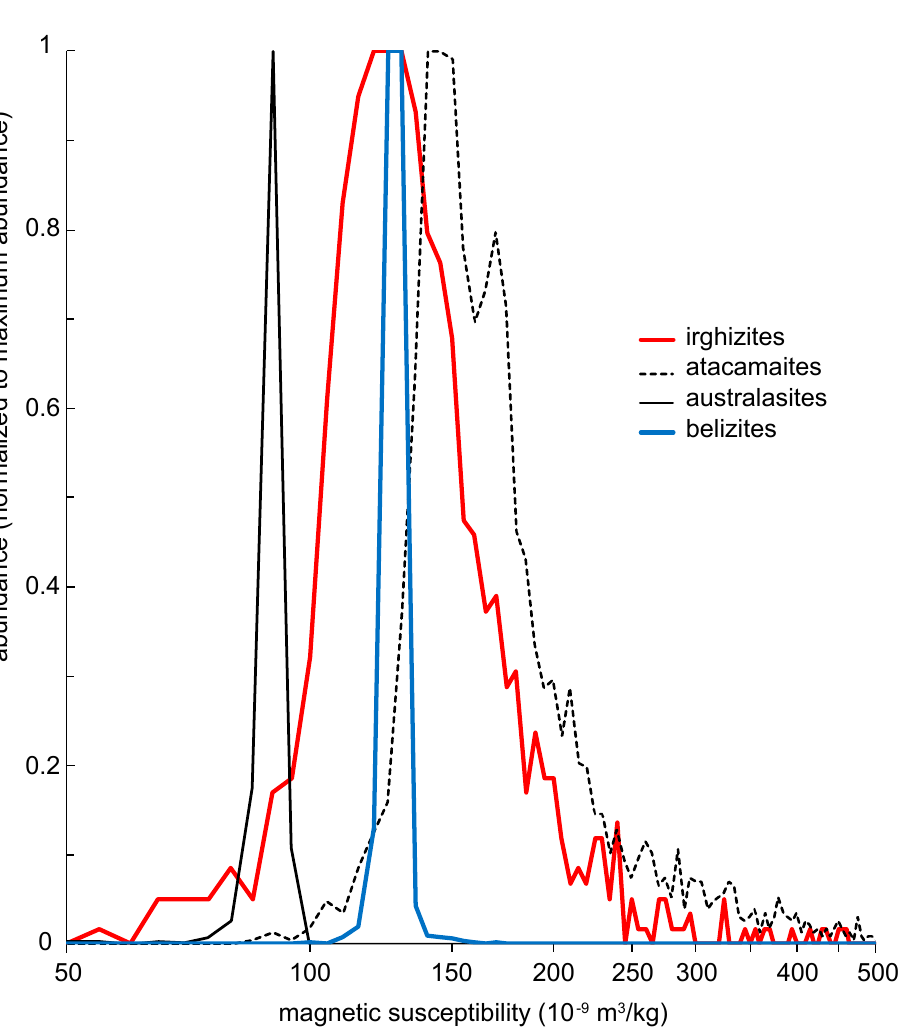
Geosciences 2019 , 9 , x FOR PEER REVIEW 20 of 25 Figure 12. Distribution of magnetic susceptibility for studied impact glasses with more than 600 Figure 12. Distribution of magnetic susceptibility for studied impact glasses with more than 600 samples measured (see Tables 1 and 3; australasite data is from the S China dataset) showing the samples measured (see Tables 1 and 3; australasite data is from the S China dataset) showing the are similar: andesitic to rhyolitic lavas [11,36]. Lavas are the only target rocks for Pantasma and di ff erent dispersion between tektites and partly ferromagnetic impact glass. Bin used is 5 × 10 − 9 m 3 / kg. different dispersion between tektites and partly ferromagnetic impact glass. Bin used is 5 × 10 − 9 m 3 /kg. El’gygytgyn while sedimentary target rocks dominate over lavas in Zhamanshin. Magnetic mineralogy of these impact glasses is dominated by substituted magnetite [9,10–12,51], as expected by their generally oxidized nature indicated for example by XANES (for LDG, Aouelloul,